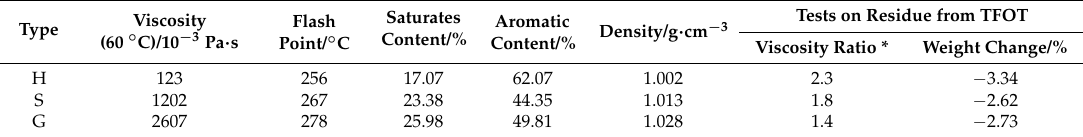
Table 2. Main properties of rejuvenating agent.